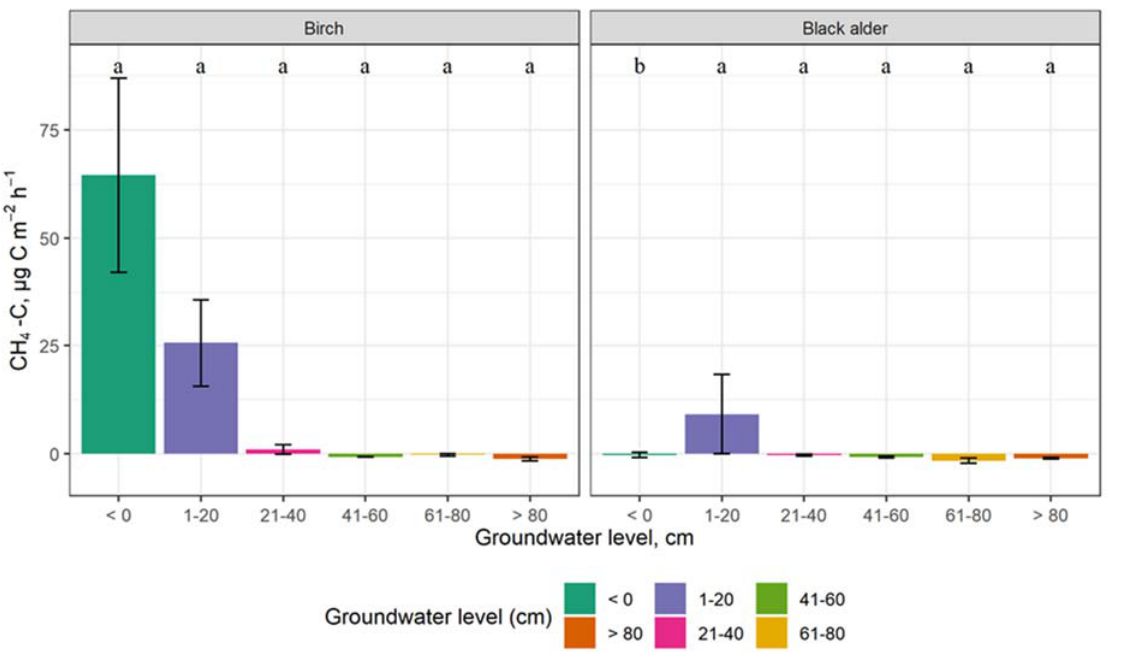
Figure 10. CH 4 fluxes and removals depending on the groundwater level in silver birch and black alder stands. Different lowercase letters show statistically significant differences ( p < 0.05, two-sample t -test) between tree species within the same groundwater level group.